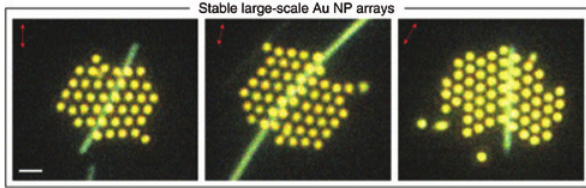
Figure 4: Dark-field images of silver nanowire-assisted optical assembly of multiple silver nanoparticles into stable hexagonal lattices. The angle of polarisation is 30 ° to the vertical plane of the image. Scale bar is 1 μ m. Reproduced with permission from